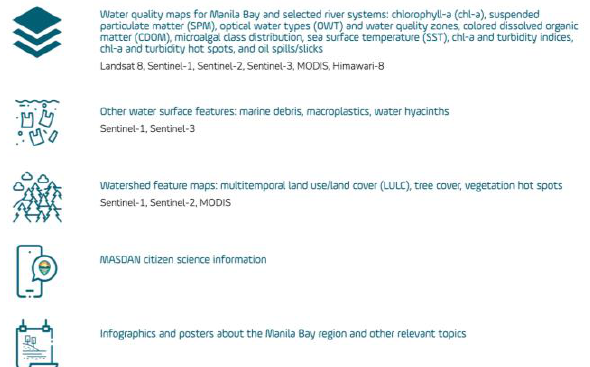
Figure 1. Project MapABLE data products publicly available in the Web Portal. Products and outputs include water quality maps for Manila Bay and selected river basins, other water surface features, watershed feature maps, MASDAN citizen science information, and infographics about the Manila Bay